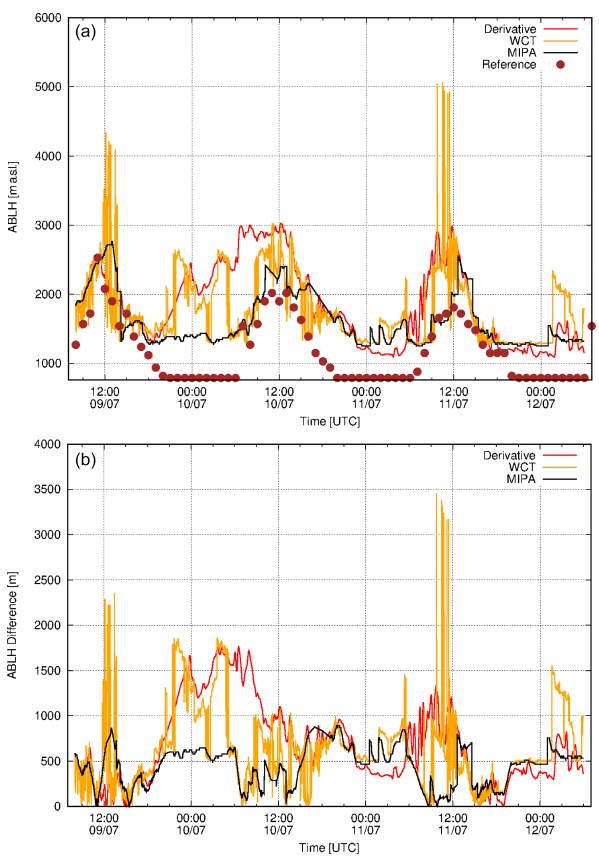
Figure 4. (a) ABLH retrieved during the 72h EARLINET exercise (9–12 July 2012) for Potenza. Black, red and yellow lines show the ABLH retrieved from 1064nm high-resolution total attenuated backscatter time series applying MIPA, derivative and WCT al- gorithms, respectively. Brown circles are the reference ABLH as retrieved from atmospheric temperature and pressure profiles pro- vided by ECMWF forecasts. (b) Absolute differences of the re- trieved ABLHs with respect to the reference. The original time reso- lution of ECMWF forecasts data is 1h. They have been interpolated at the lidar data time resolution (60s).